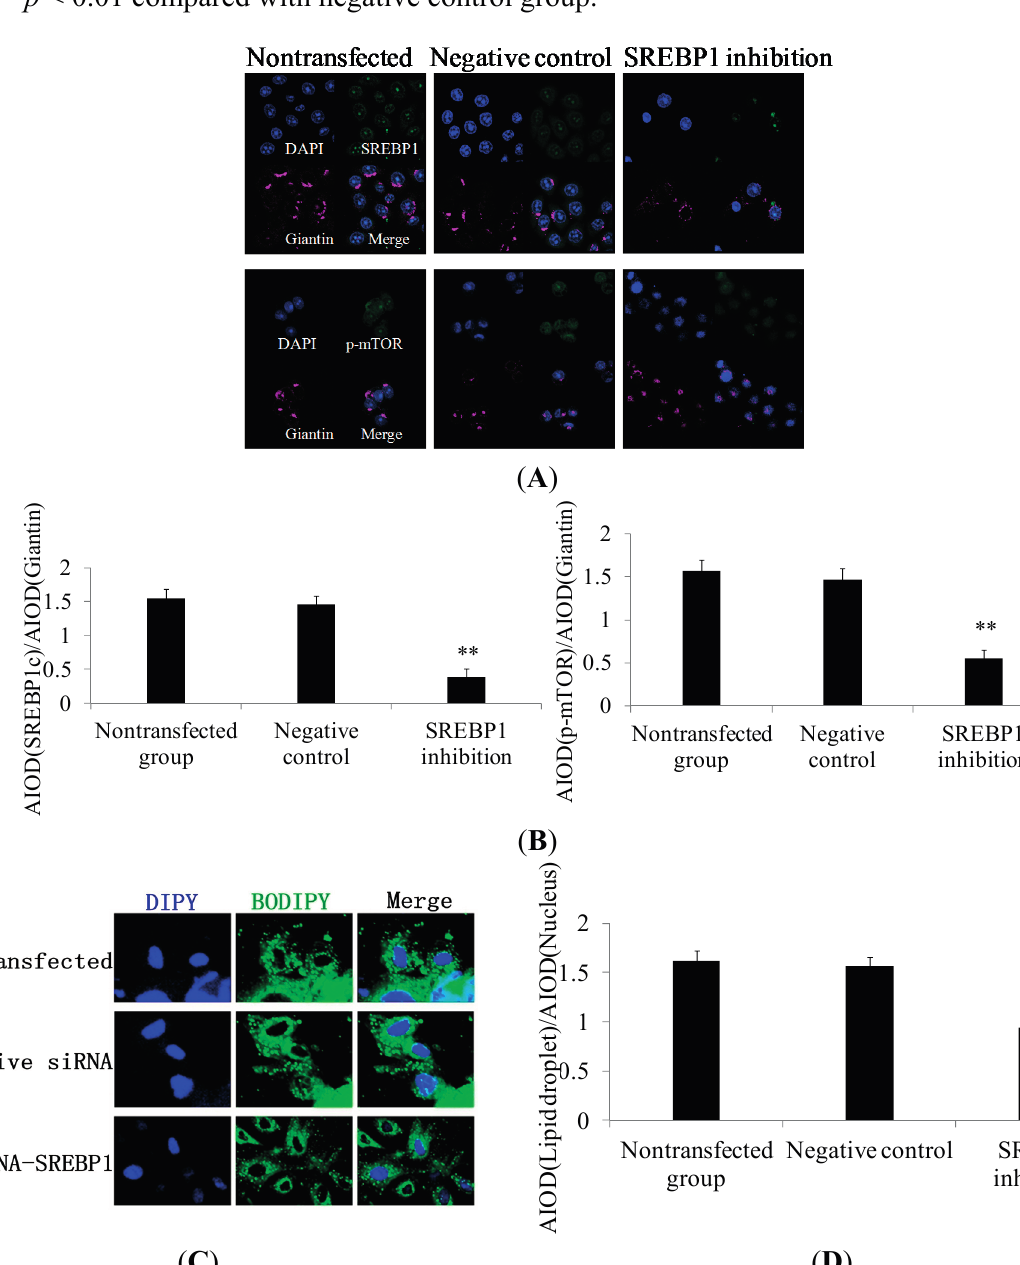
Figure 3. Effect of SREBP1 gene silencing on the subcellular localization of molecules related to milk fat synthesis in DCMECs. Groups of DCMECs were assessed as in Figure 2. ( A ) Localization and integral optical density analysis of SREBP1 and p-mTOR. SREBP1 and p-mTOR (green), giantin (purple), and DAPI (blue). Scale bars = 10 μ m; ( B ) Integral optical density analysis of SREBP1 and p-mTOR. p-mTOR (green), giantin (purple), and DAPI (blue). Scale bars = 10 μ m; and ( C , D ) Immunofluorescent staining and integral optical density analysis of lipid droplets were performed on DCMECs. Lipid droplet (green) and DAPI (blue). Scale bars = 10 or 15 μ m. Values represent means ± SE ( n = 3). ** p < 0.01 compared with negative control